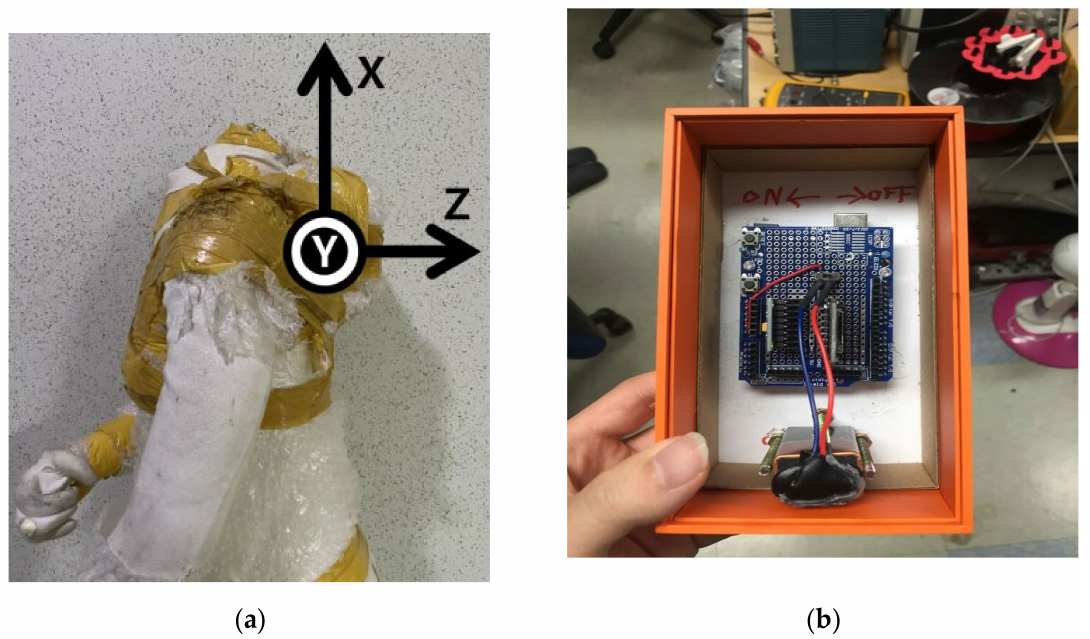
Figure 2. Three-axis of MPU 6050: ( a ) X, Y, Z axes indicated the head, arm, and body directions; ( b ) MPU6050 with